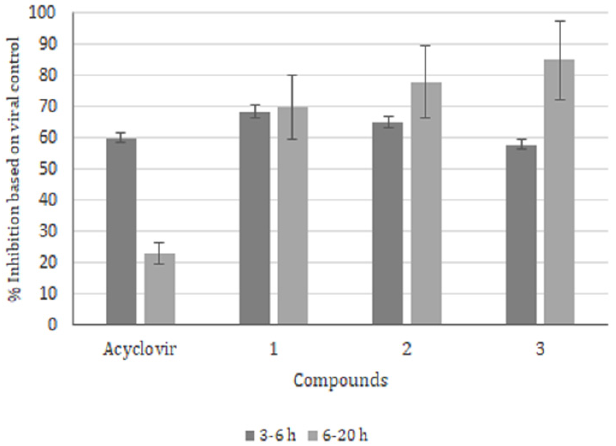
Figure 3. Attachment assay. Vero cells (3 × 10 5 cells/well) were incubated for 2 hours with HSV (MOI = 0.1) at 4 °C in the presence or absence of 2-aminomethyl-3-hydroxy-1,4 naphthoquinones encapsulated into liposomes. The level of infection was determined 48 h later by plaque-forming unit counts. The results were expressed as Mean ± SD of three independent experiments. P < 0.05 control group.